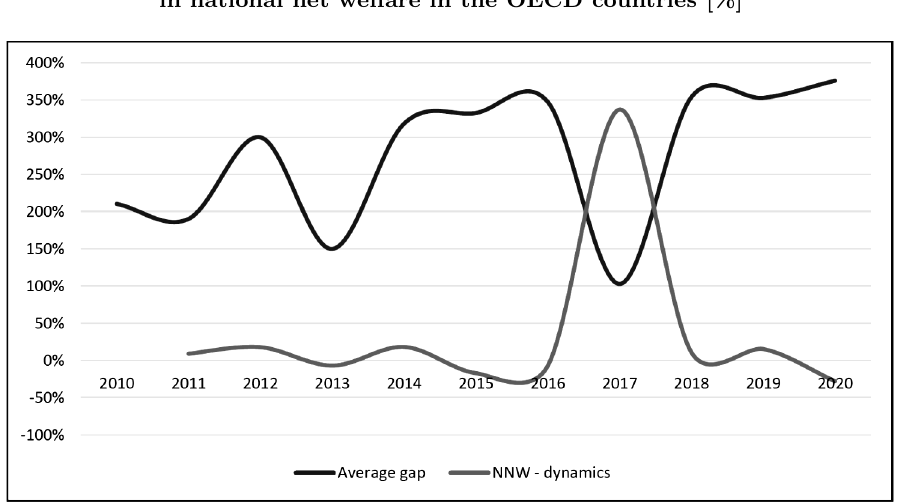
Average loans mismatch on the public balance sheet and the change in national net welfare in the OECD countries